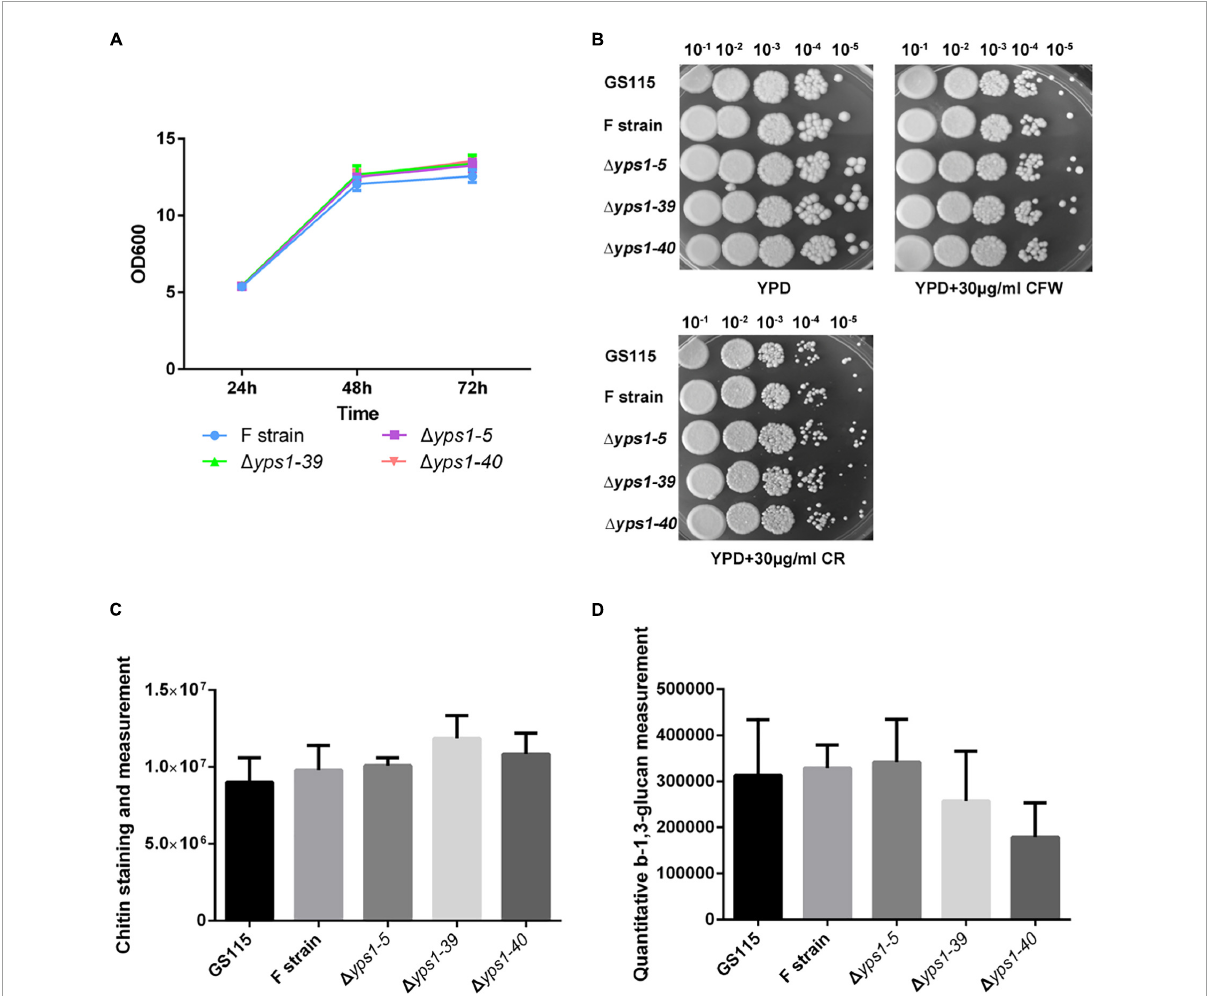
FIGURE2 Cell growth and phenotypic analysis of yps1 -disrupted strain. (A) Cell growth characteristics of yps1 -disrupted strain versus wild-type strain in the BMMY culture medium. (B) Sensitivity of yps1 -disrupted cells to CR and CFW. GS115, F, and yps1 -disrupted strains were grown to mid-log phase and normalized to an OD 600 of 1.0. The cells were diluted five times in a 10-fold series, and 2 µ l of each dilution were spotted on YPD plates containing 30 µ g/ml of CR or CFW. (C) Chitin staining and measurement. The cell grown in YPD at 24 h were collected by centrifugation at 3,000 × g for 5 min, and cells were stained with 20 µ g/ml CFW. (D) Relative content of β -1,3-glucan. Cells were grown in YPD medium to OD 600 1.0 and 5.0 × 10 7 cells were harvested by concentration at 6,000 × g for 3 min. The β -1,3-glucan content in the cell wall was measured with aniline blue. Three biological replicates were performed because of the low precision of the β -1,3-glucan measurement with aniline blue. The contents of chitin and β -1,3-glucan are no statistical difference between wild-type and yps1 -disrupted strain. Error bars indicate means ± standard deviation (SD) ( n = 3).